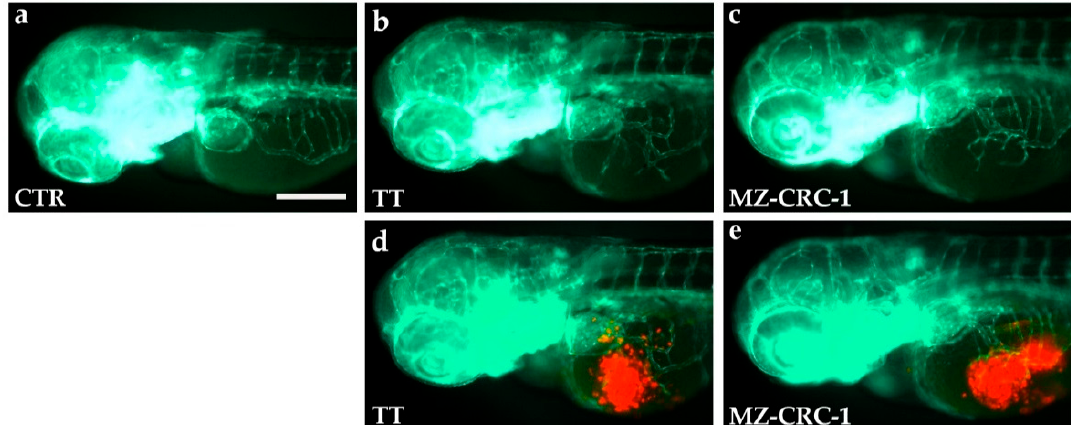
Figure 5. TT and MZ-CRC-1 implanted cells stimulate angiogenesis in zebrafish embryos after only 24 h post-injection. Representative fluorescence images of 72 hpf Tg(fli1a:EGFP) y1 zebrafish control embryos ( a ) and embryos implanted at 48 hpf with TT ( b , d ) and MZ-CRC-1 cells ( c , e ). The red channel, corresponding to TT or MZ-CRC-1 cells, was omitted in panels b and c to highlight the tumor-induced microvascular network. Compared to the control, grafted embryos showed vessels in green that sprout from the sub-intestinal vein (SIV) toward the xenograft of both cell lines. Embryos are shown anterior to the left. Scale bar: 100 µm.